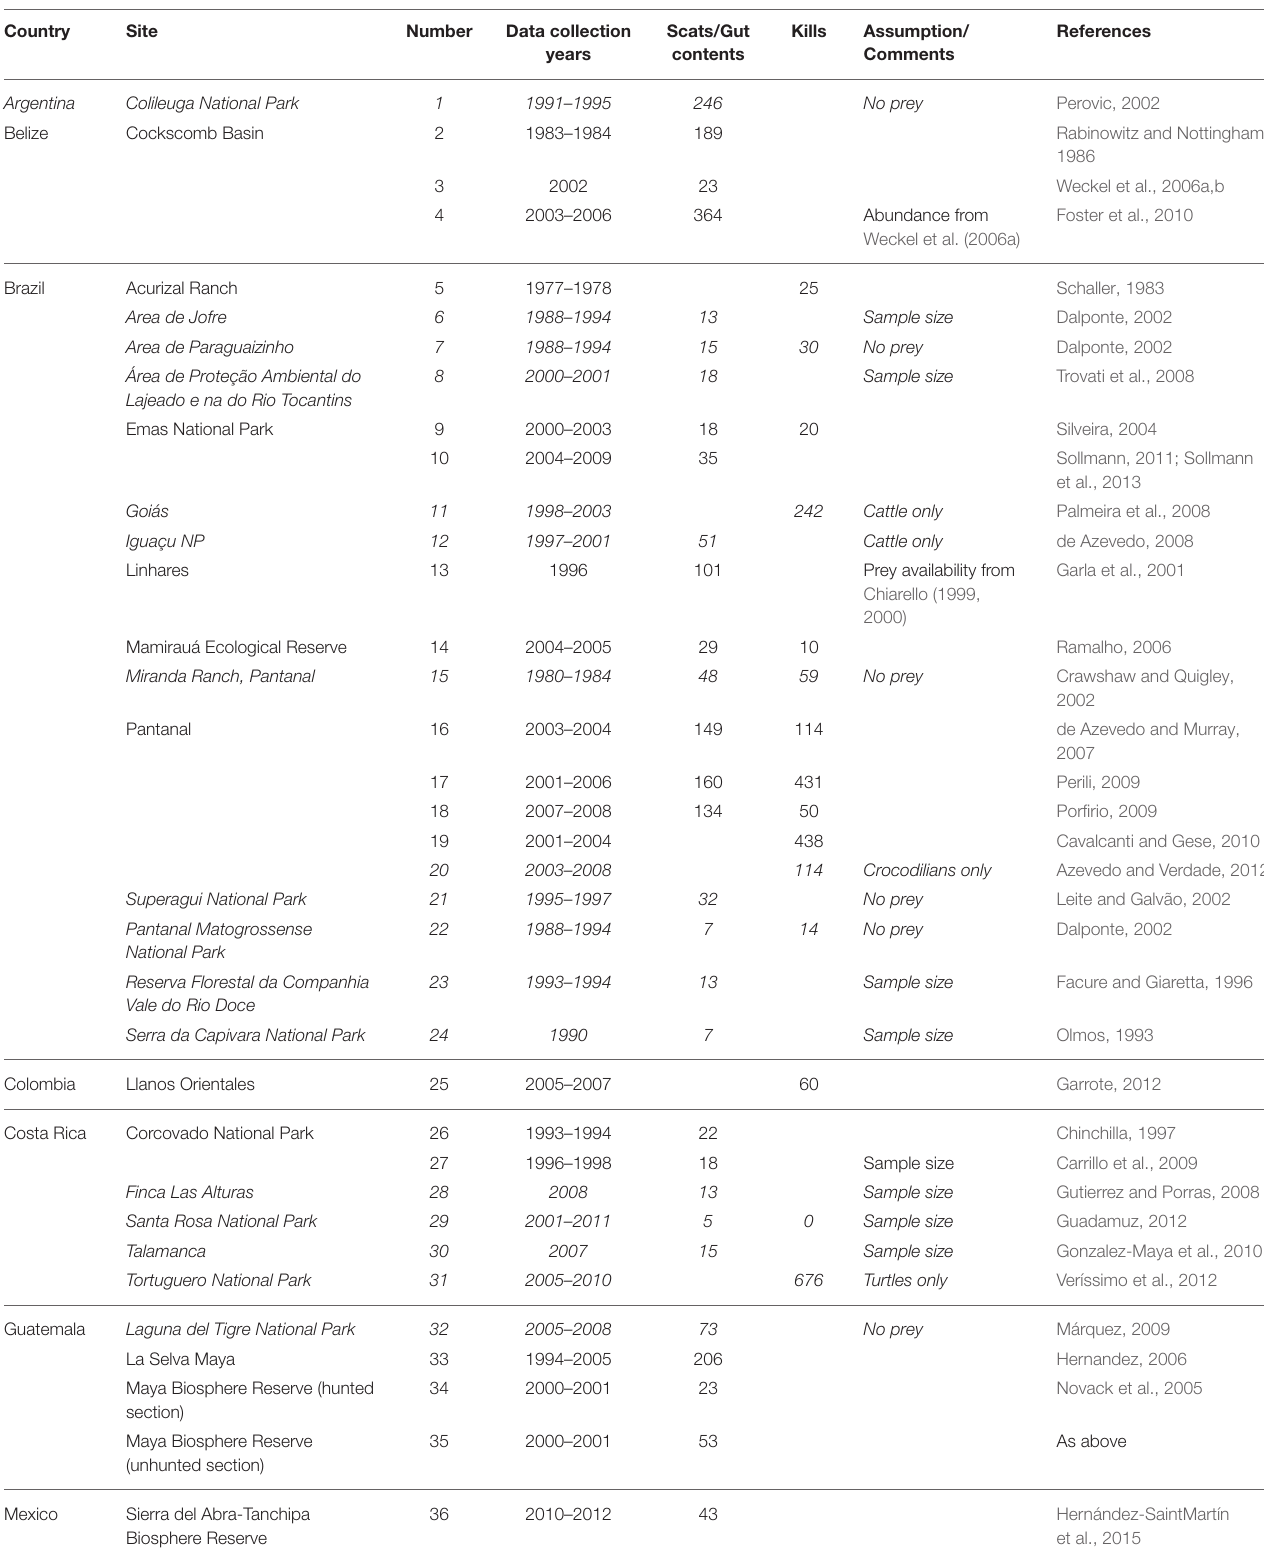
TABLE 1 | Details on studies found and used in this meta-analysis including location, sample sizes, diet analysis method, and any assumptions made.